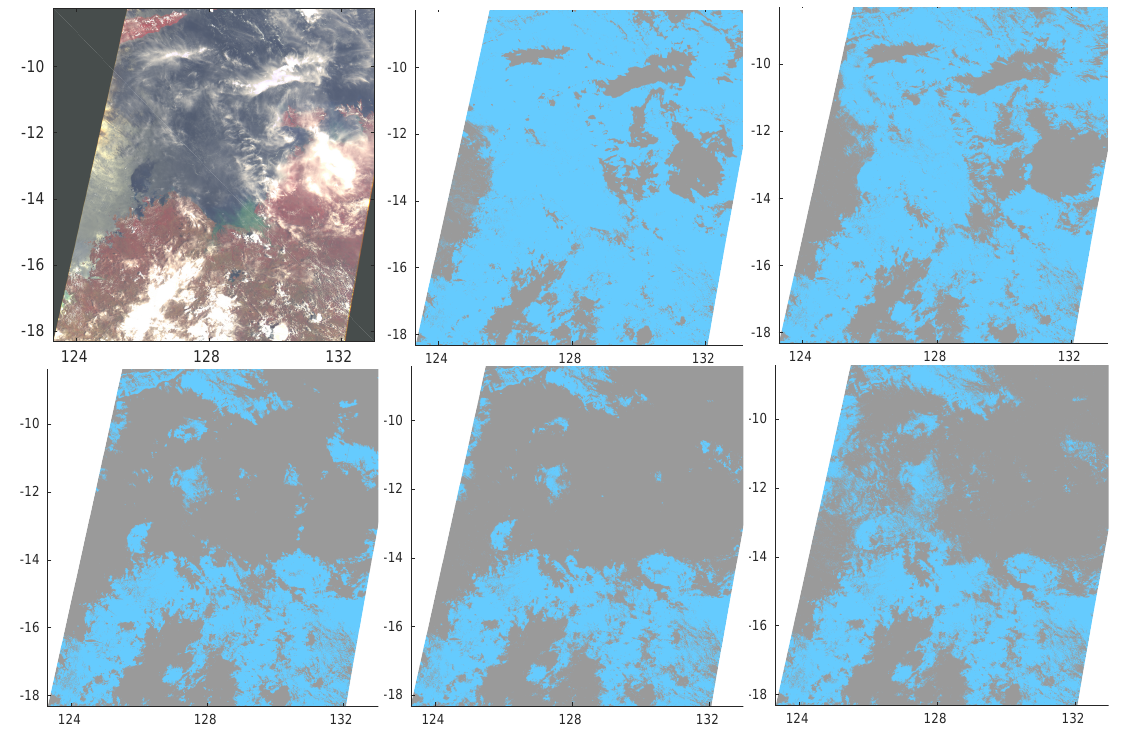
Figure 6. RGB image acquired on 21 December 2014 at 02:29 UTC over North Australia (top-left panel). Other panels show cloud masks obtained by LDA, PCDA, CDA, ANN and KNN (orderly from left to right and from top to bottom). Classification was made separately for each type of surface.